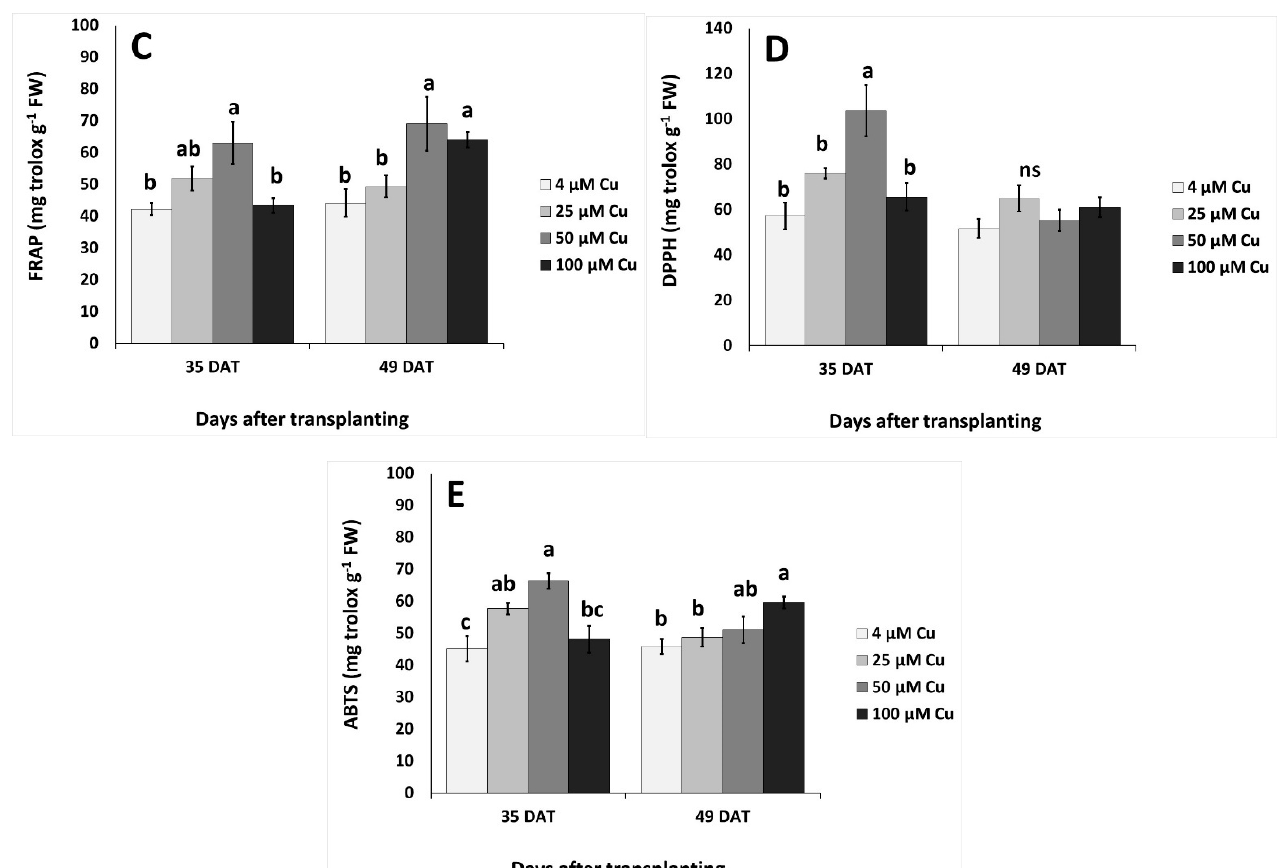
Figure 2. Effect of increasing copper (Cu) concentration (4–25–50–100 µ M Cu 2+ ) in the nutrient solution and sampling date after transplanting (DAT, 35 days and 49 days) on the leaf content of total phenols, total flavonoids and antioxidant activity in pelargonium plants grown hydroponically in perlite. ( A ) Total phenols, ( B ) total flavonoids, ( C ) FRAP ( D ) DPPH, and ( E ) ABTS. Significant differences ( p < 0.05) among Cu concentrations at each sampling date are indicated by different letters; ns indicates non-significant. Error bars show SE ( n = 4).